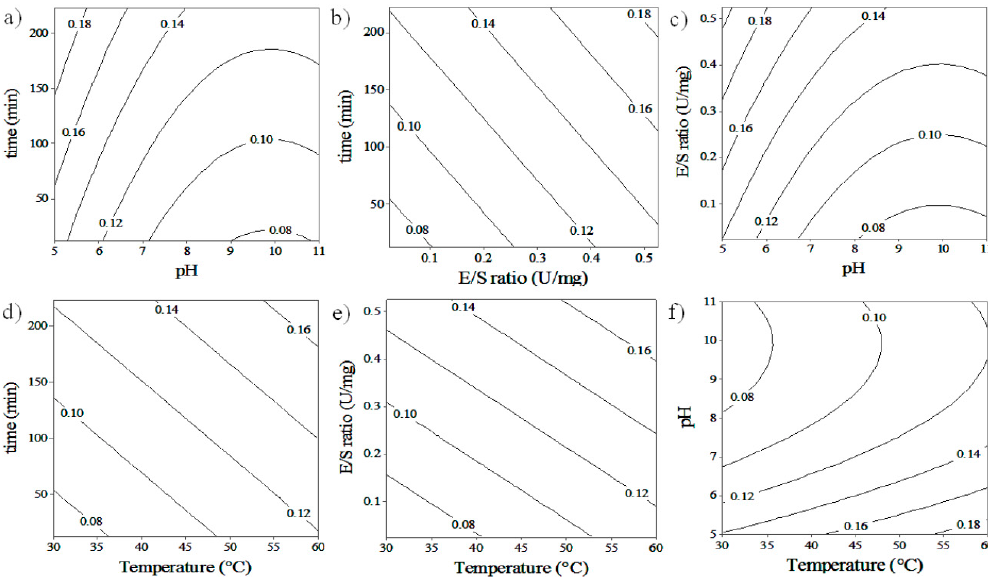
Figure 3. Contour plots depicting the interactive effect of two factors over the liberation of reducing group from hydrolysis of potato galactan by C. thermocellum galactanase. ( a ) pH * time; ( b ) E/S * time; ( c ) pH * E/S; ( d ) temperature * time; ( e ) temperature * E/S; ( f ) temperature * pH.